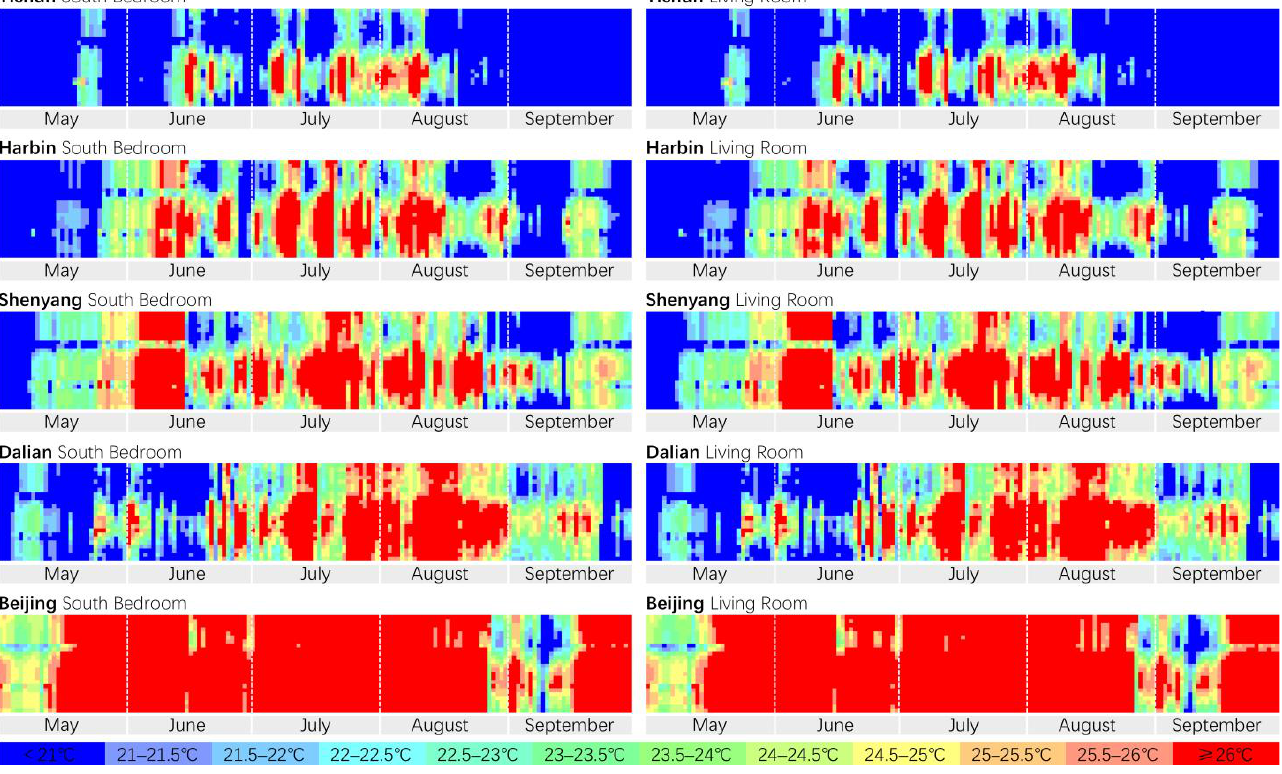
Figure 15. Indoor operative temperature (°C) in south bedroom and living room on 10F of five cities. Table 16. Urban latitude and recommended maximum W